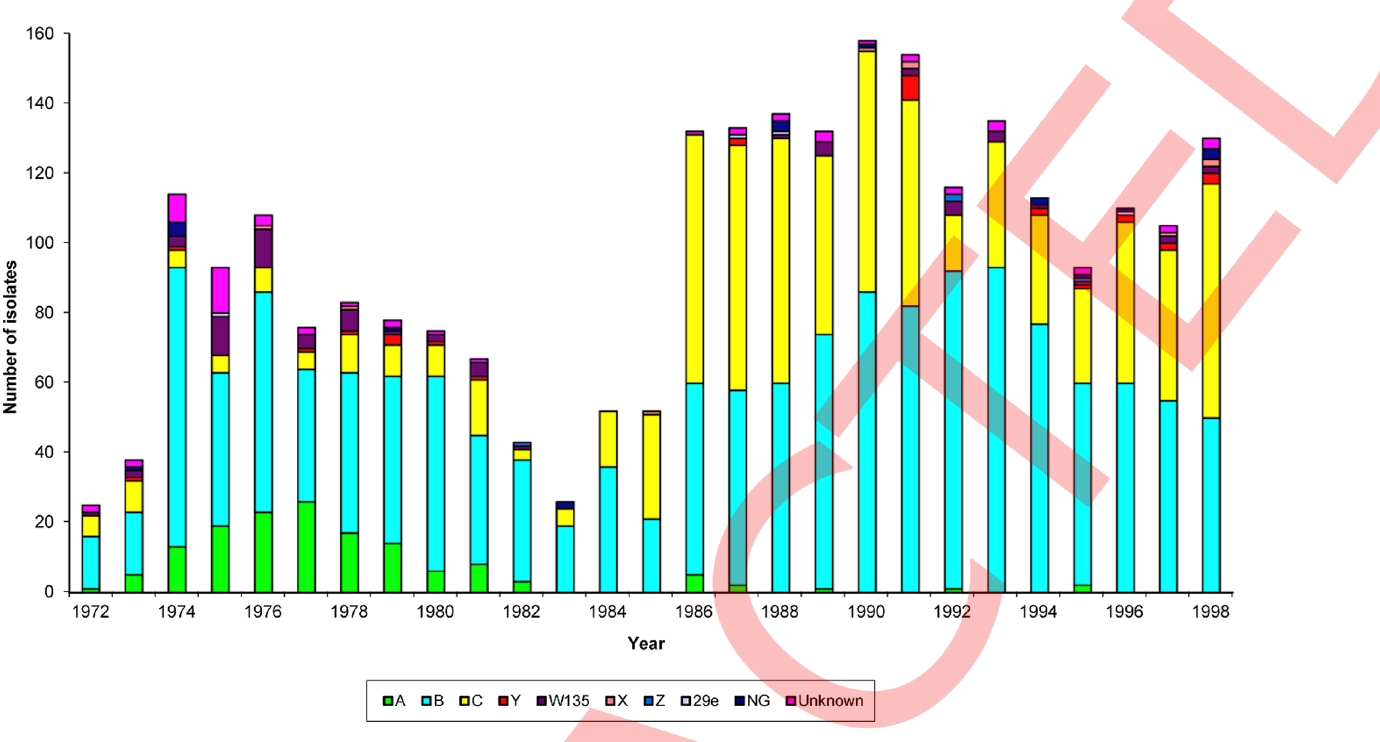
Fig. 1. Distribution of invasive isolates associated with each serogroup, Scotland 1972-98.